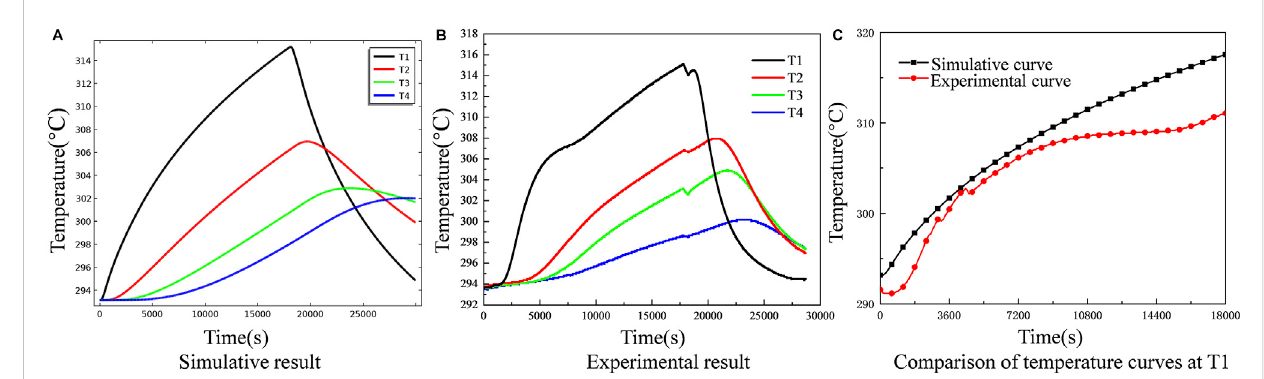
FIGURE 6 Temperature curve and comparison of measuring points in experiment and simulation (A) Experimental result (B) Simulative result (C) Comparison of temperature at T1.